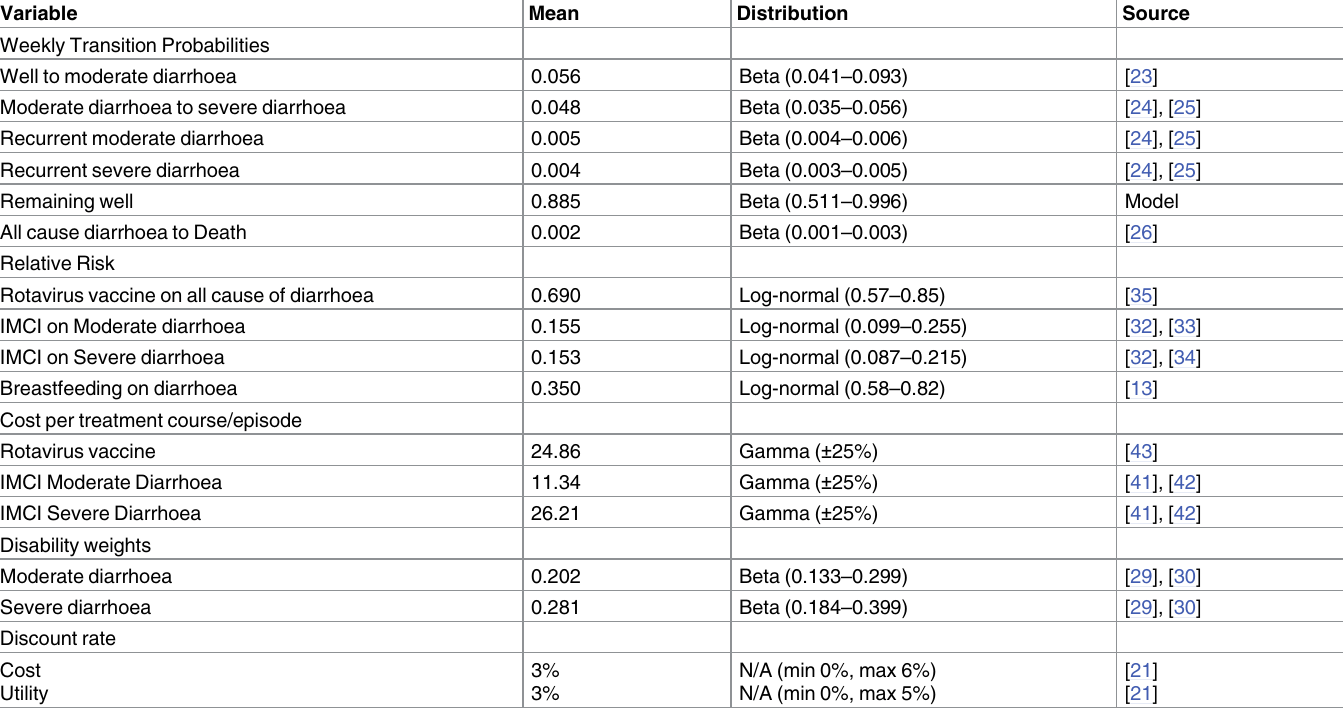
Table 2. Parameters input and distribution in the Markov